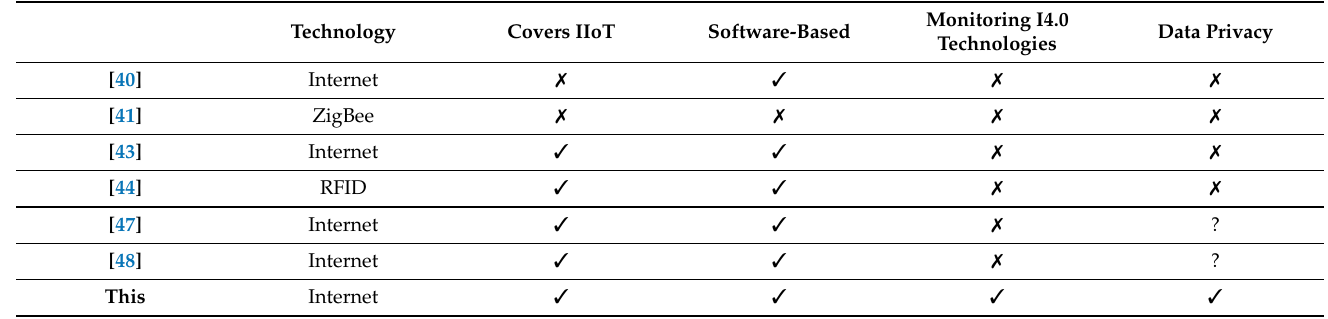
Table 2. Monitoring systems comparison.